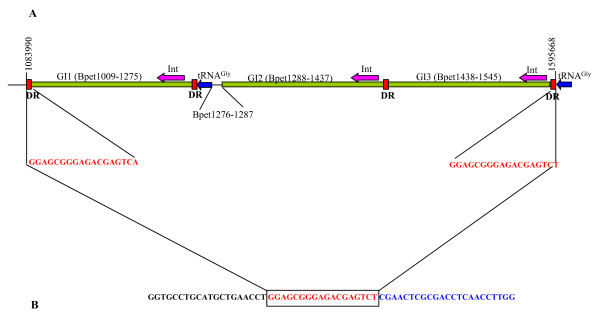
Schematic representation of the region encompassing GI1, GI2 and GI3 in the wild type strain (A) and in a spontaneous deletion variant (B). The duplicated sequence at the insertion site is shown in red and marked as DR. The position of the tRNAGly genes (blue) are indicated, as well as the location of the integrase encoding genes (red arrows).